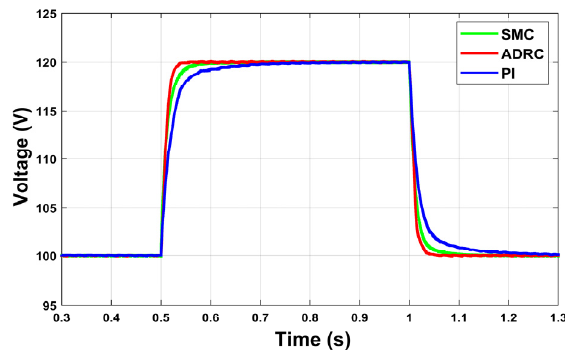
Figure 6. Output voltage responses.